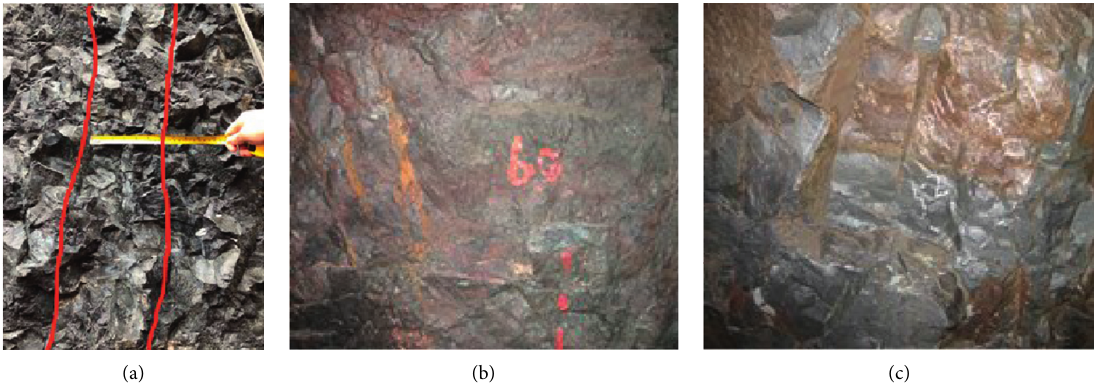
Figure 2: Field photographs of different types of rock masses: (a) CJB; (b) breccia lava; (c) cryptic